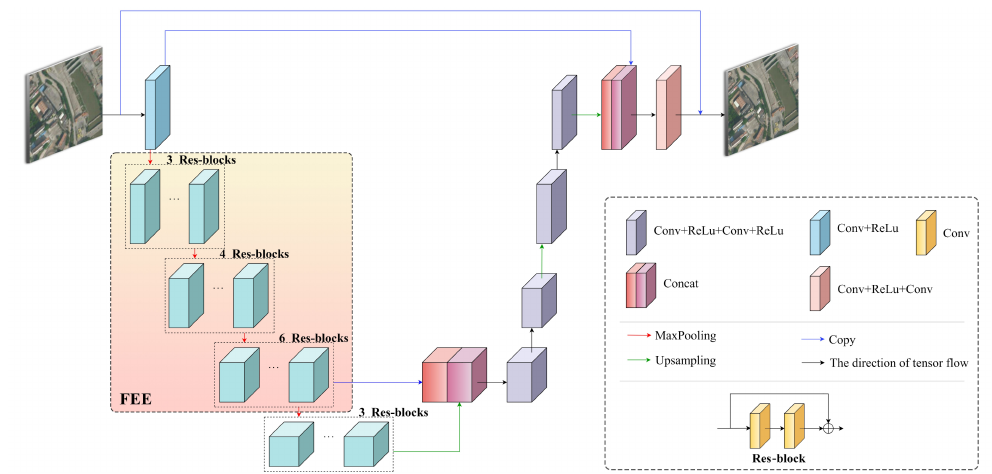
Figure 3. The structure of a multi-level self-encoder. FEE is the coding portion of the multi-level self-encoder. When pretrained with remote sensing images, FEE is prone to extracting appropriately similar features from the LR and Ref